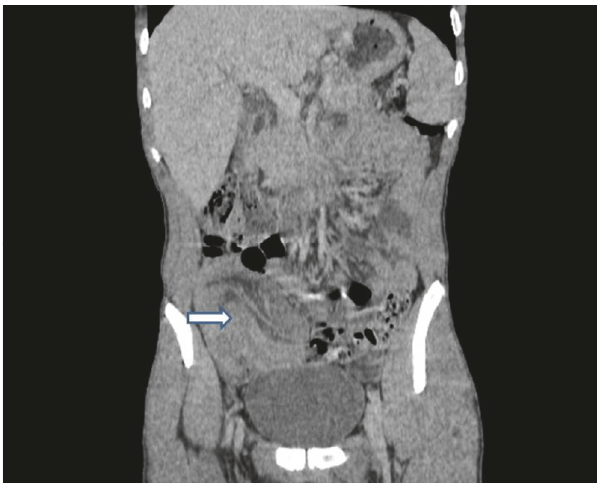
Figure 1: Coronal CT scan of the abdomen and pelvis showing a pseudokidney mass (arrow).